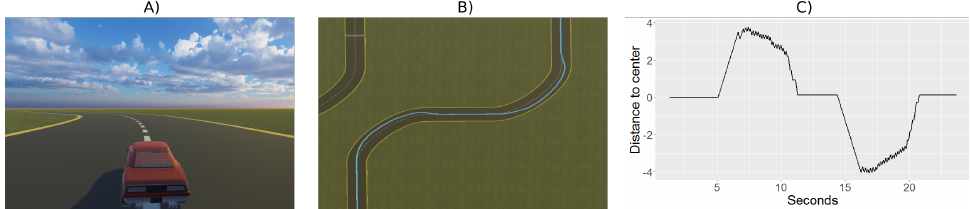
Figure 1. Car driving video game. ( A ) User view. ( B ) Example of a recorded trajectory (in blue). ( C ) Error graph over